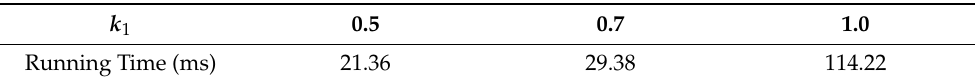
Table 3. Performance measure for real time; state of curved road, k 2 = 0.3, length 100 m, and nObstacles